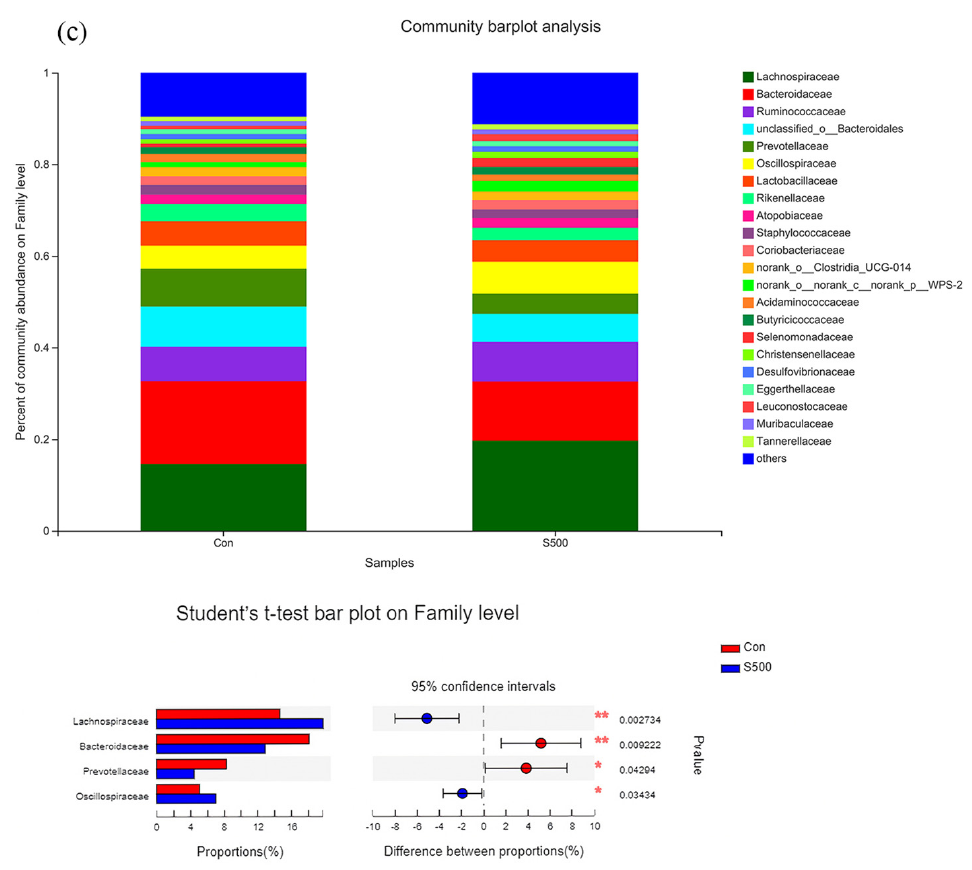
Figure 7. Microbial composition and significant differential bacteria in the cecum of laying hens at the phylum level ( a ), class level ( b ), and family level ( c ). Statistical differences between the two groups were calculated by Student’s t -test with Welch’s correction. * p < 0.05 and ** p < 0.01. Significant differences in the microbial compositions between the control and S500 group were further identified using linear discriminant analysis (LDA) combined with effect size (LEfSe). LDA and LEfSe analyses were used to differentiate the gathering of specific bacterial taxa whose abundance varied with dietary CSB levels and thus could serve as biomarkers. Figure 8 displayed the species with significant differences with an LDA score > 2.0. Results showed Prevotellaceae as a biomarker of the control group, while Clostridia , Lachnospirales , Oscillospirales, and Gastranaerophilales , which are known to SCFAs producers, were biomarkers of the S500 group.